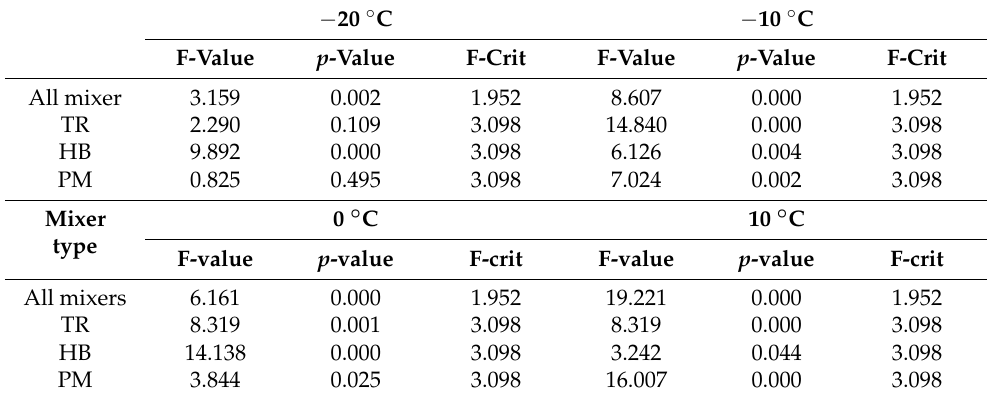
Table 9. One-way ANOVA of ITSM results at − 20, − 10, 0, and 10 ◦ C (significance level =